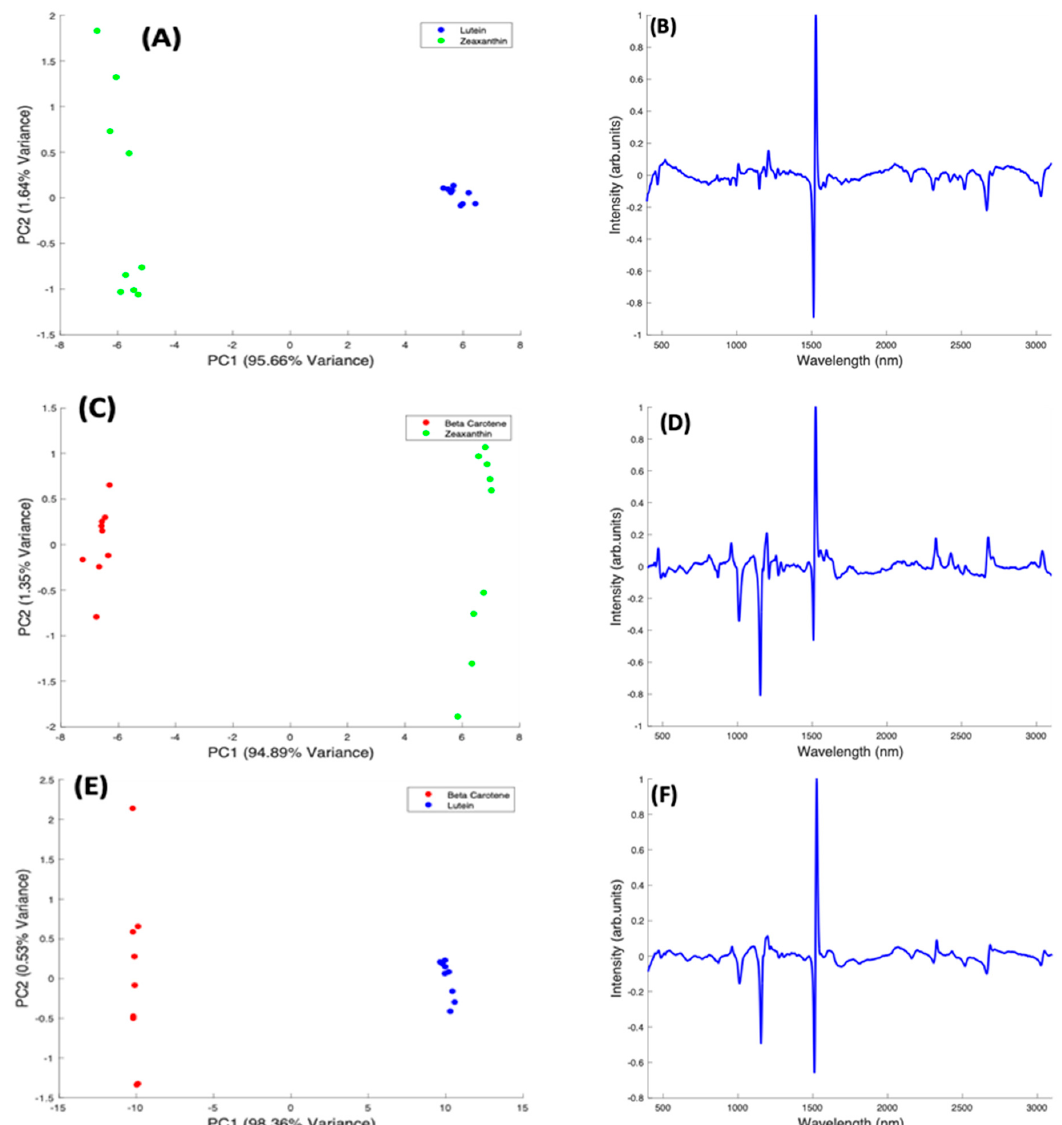
Figure 9. Pairwise PCA analysis for Lutein and Zeaxanthin, and Beta Carotene. ( A ): Scatter plot scores for the first two principal components from PCA of Lutein and Zeaxanthin. ( B ): Plot of PC1 loading for Lutein and Zeaxanthin. ( C ): Scatter plot scores for the first two principal components from PCA of Beta Carotene and Zeaxanthin. ( D ): Plot of PC1 loading for Beta Carotene and Zeaxanthin. ( E ): Scatter plot scores for the first two principal components from PCA of Beta Carotene and Lutein. ( F ): Plot of PC1 loading for Beta Carotene and Lutein.